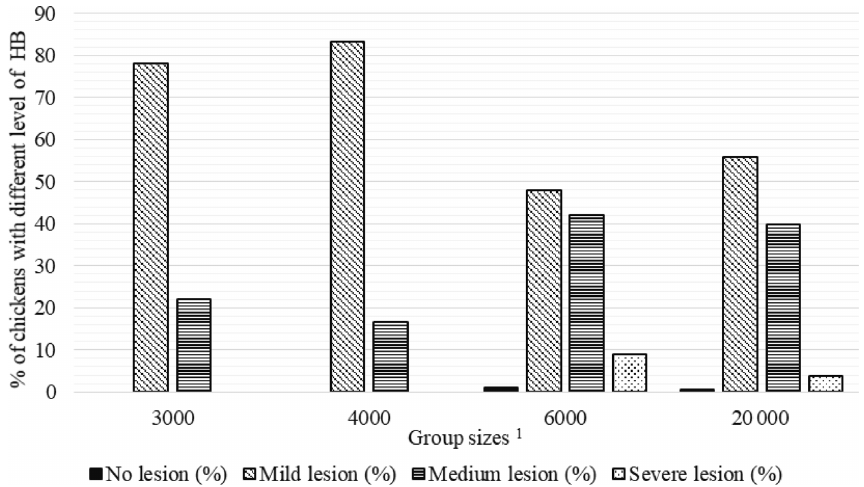
Figure 2. Percentage of chickens with different level of hock burn (HB) in varying group sizes. 1 The 3000, 4000, 6000, and 20000 numbers represent the number of chickens in the each group